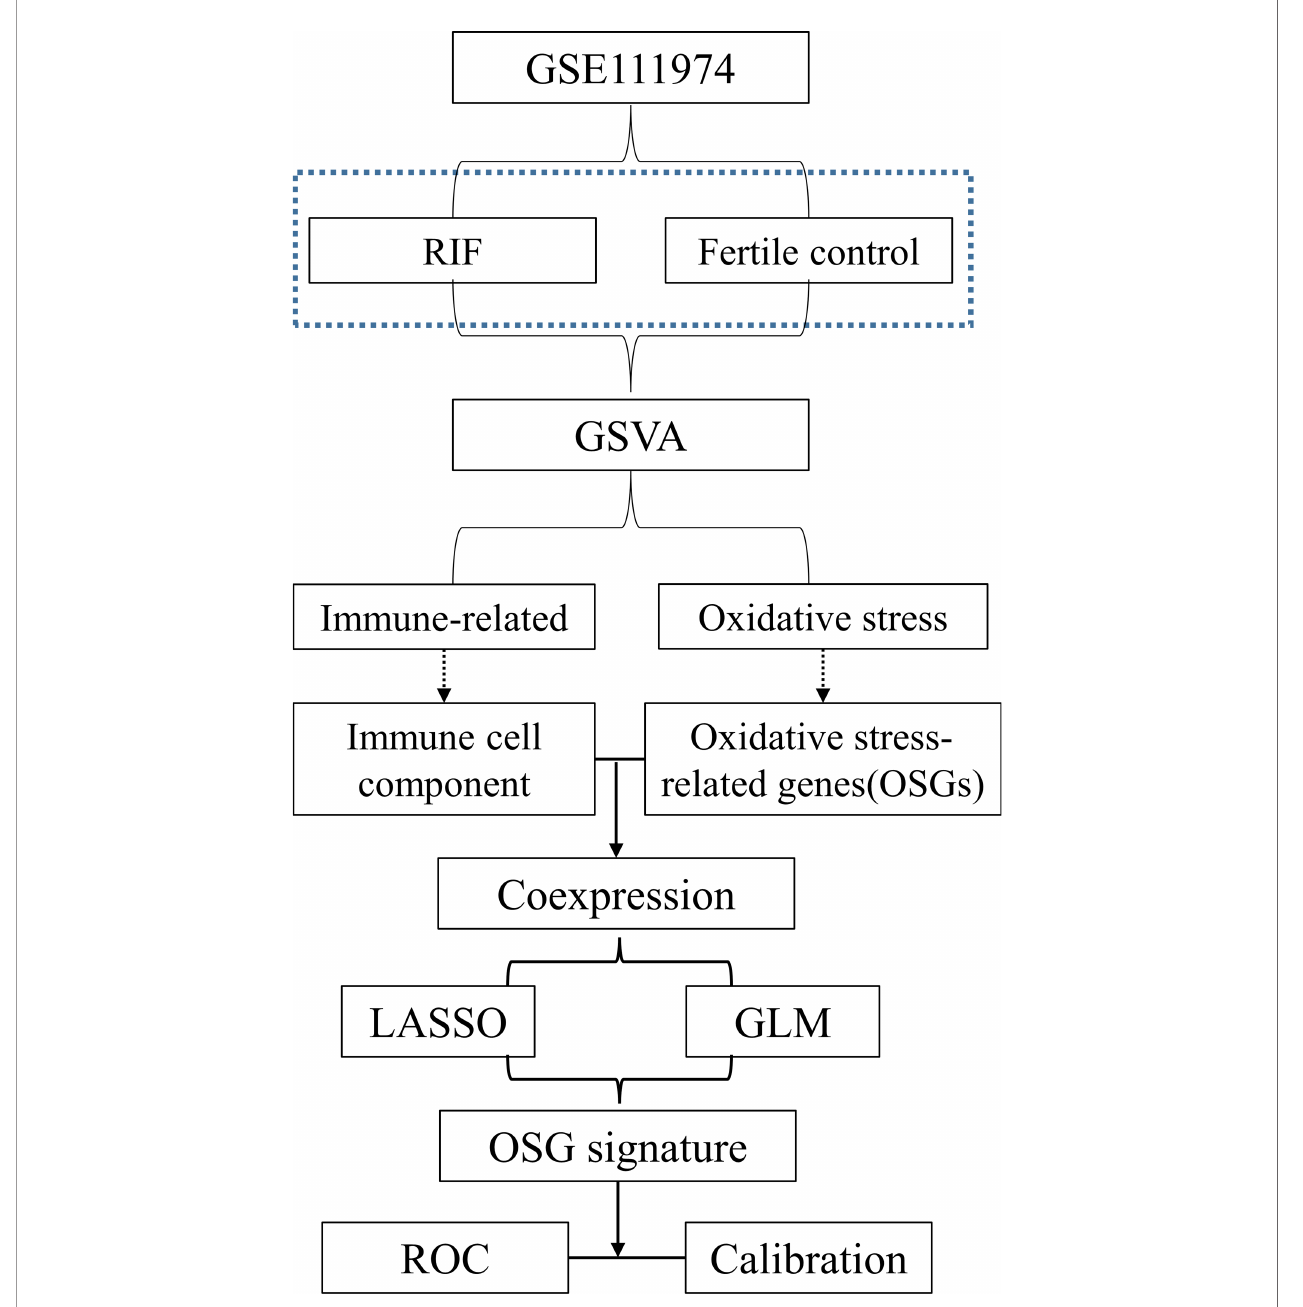
FIGURE 1 | Flow chart of data preparation, processing,